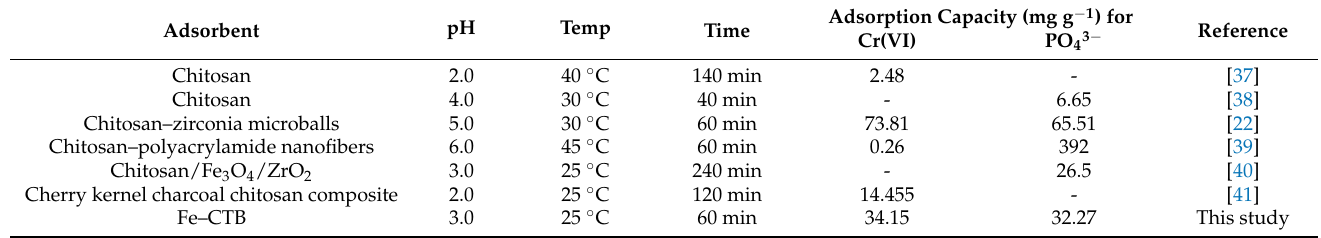
Table 4. Comparison of Fe–CTB for Cr(VI) and phosphate sorption with reported